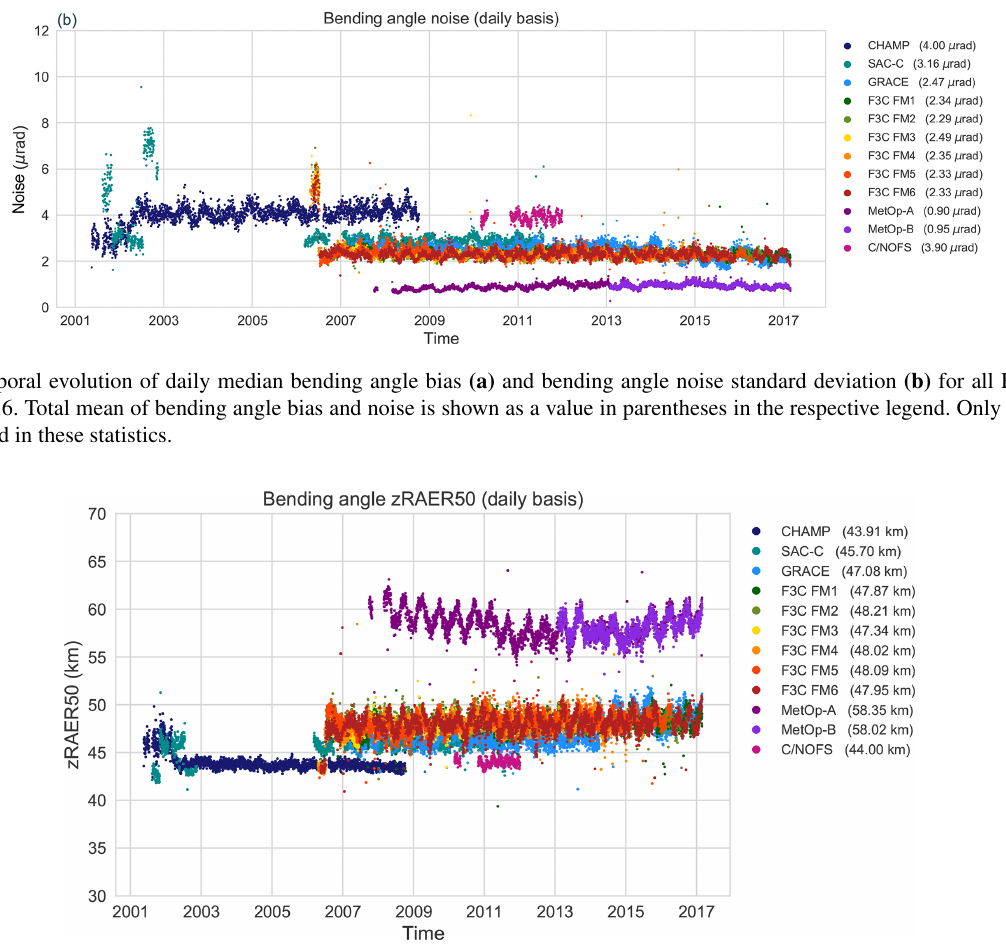
Figure 7. Temporal evolution of daily mean bending angle zRAER50 for all RO missions processed in OPSv5.6. The total mean of zRAER50 is shown as a value in parentheses in the legend. Only high-quality profiles are used in these